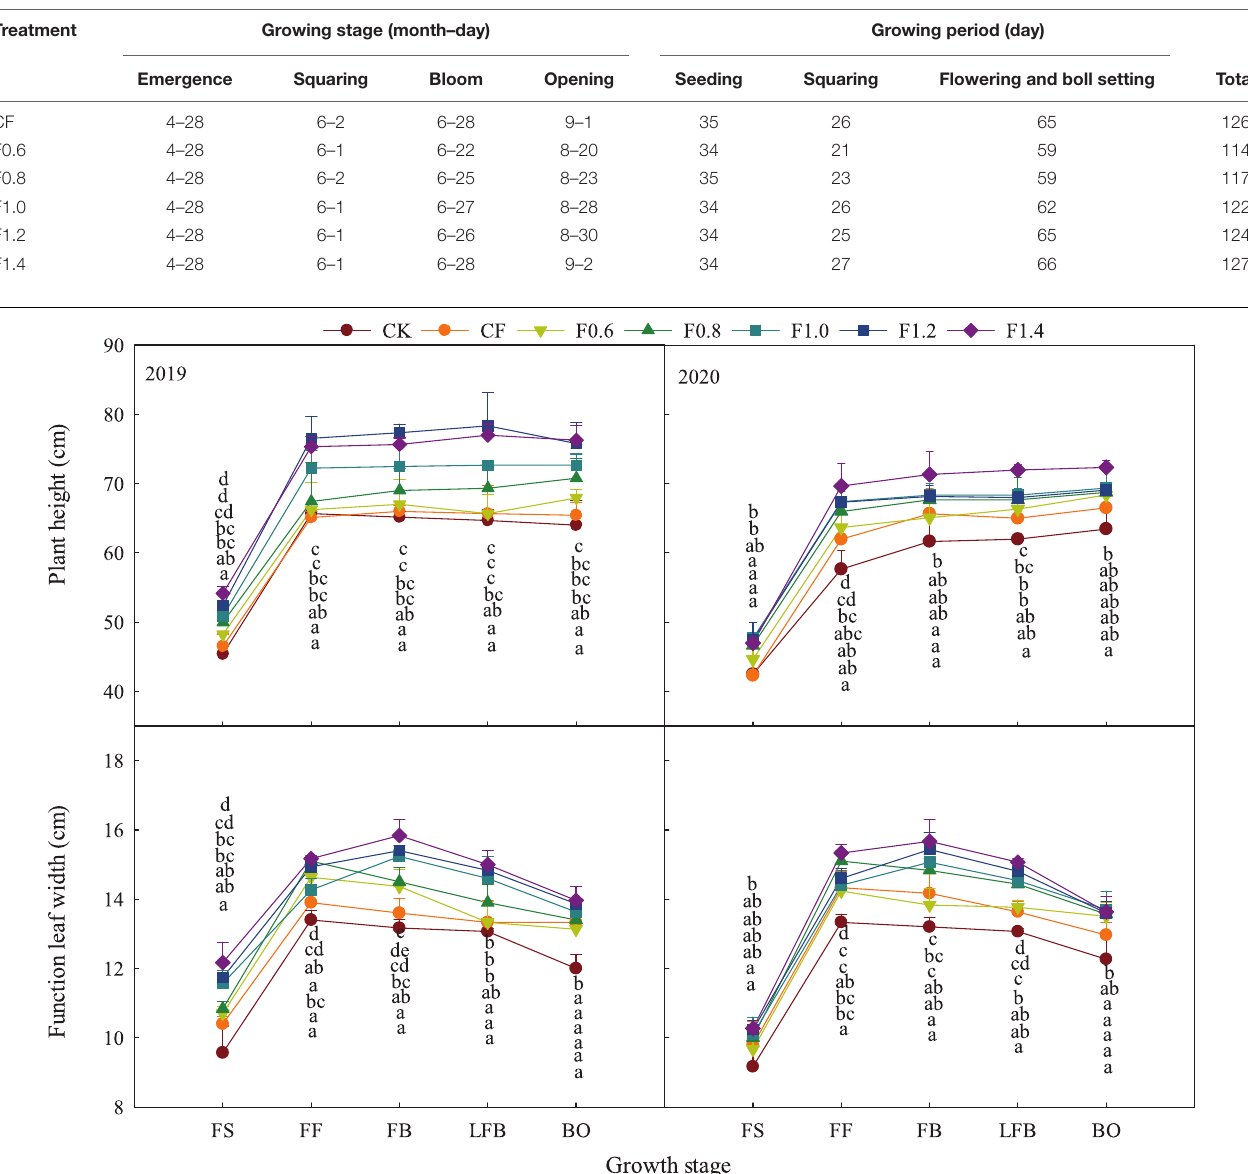
TABLE 2 | Effect of different fertilization schedules on the cotton growing stages and periods (2020). Treatment